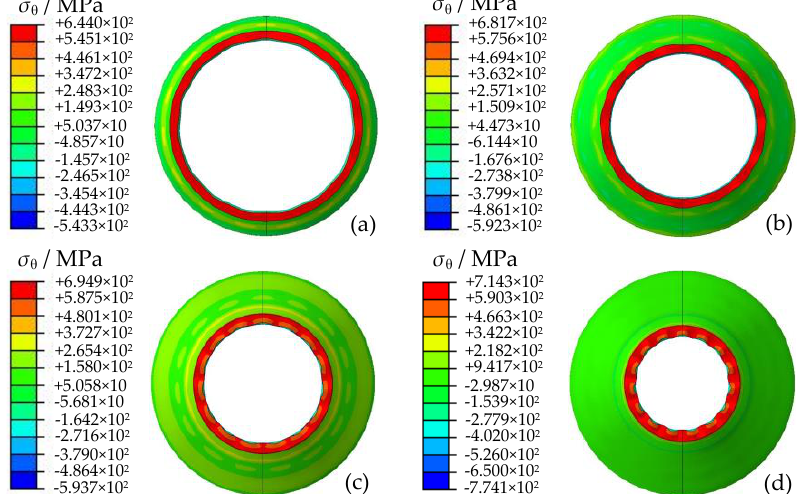
Figure 22. Four-pass reduced tubes of T 0 = 1.2. ( a ) The first pass; ( b ) the second pass; ( c ) the third pass; ( d ) the fourth pass.